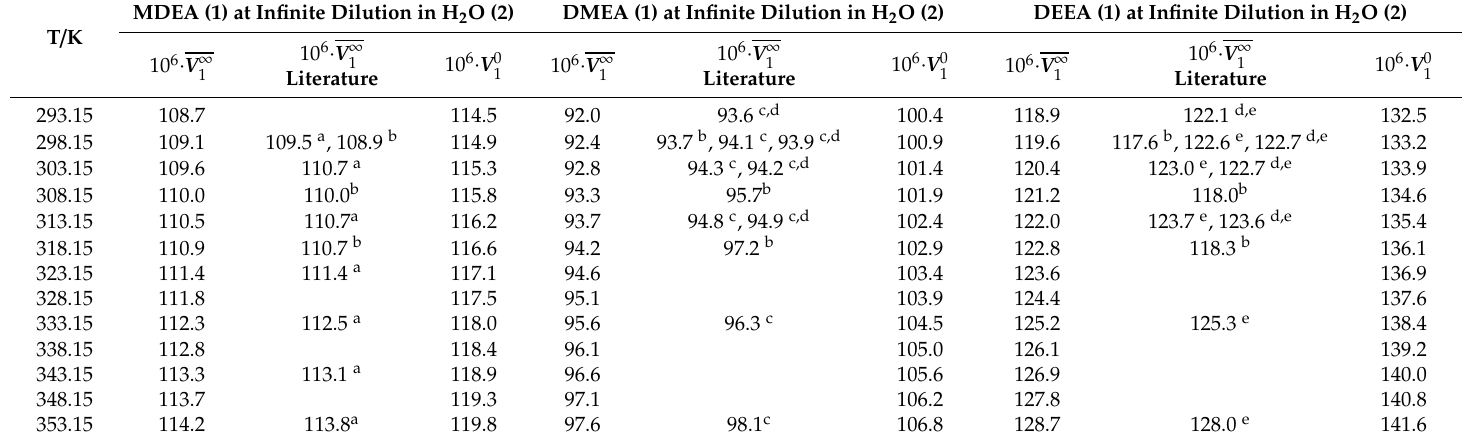
Table A4. Partial molar volume V ∞ various